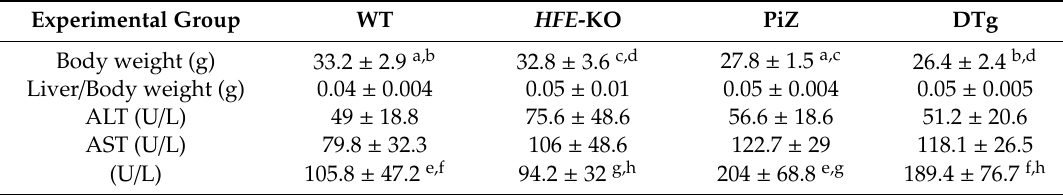
Table 3. Liver values, serum parameters and body weights in 18 months old mice.